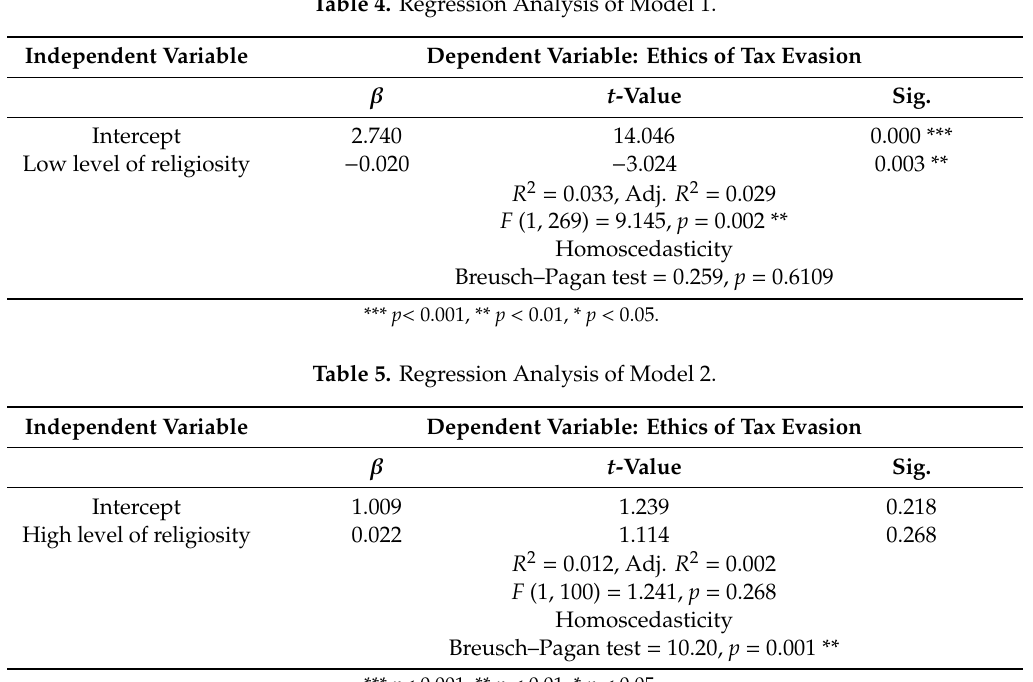
Table 4. Regression Analysis of Model 1.